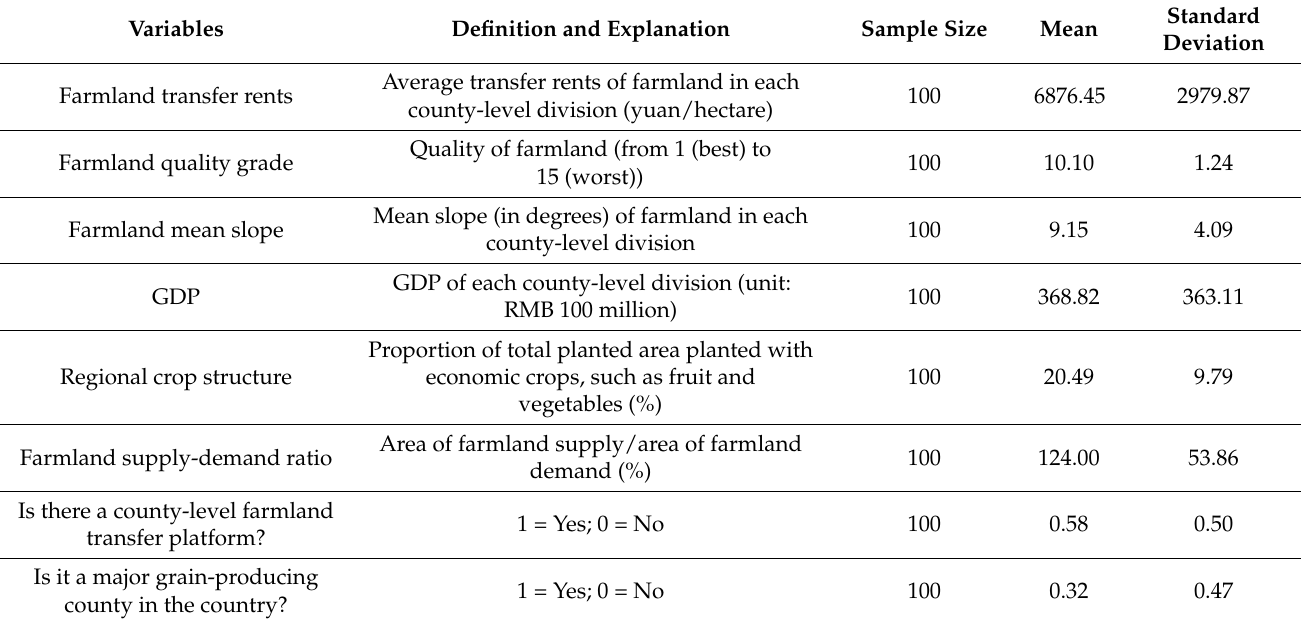
Table 2. Definitions and descriptive statistics of